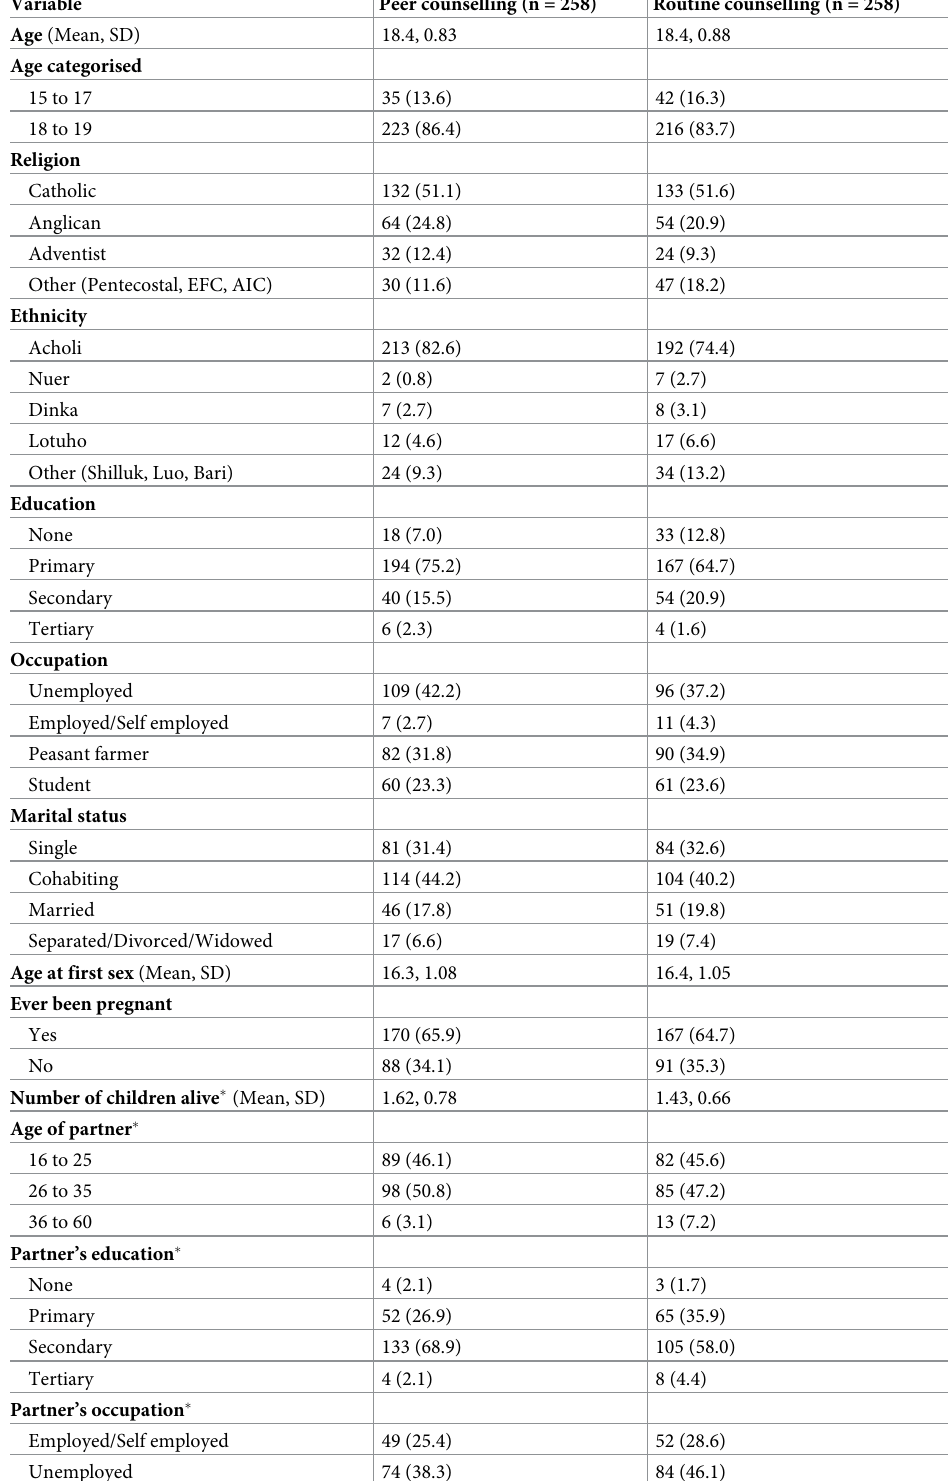
Table 1. Background characteristics of the study